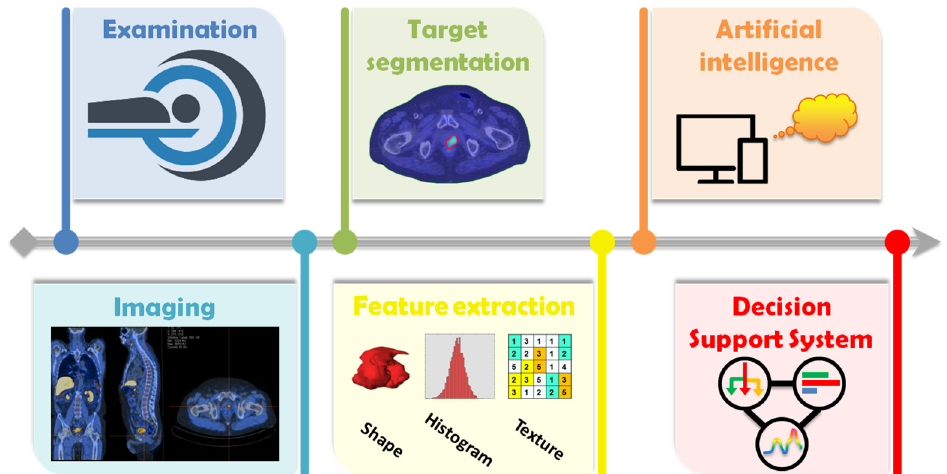
Figure 1. The radiomics framework depicts all the steps needed to build a radiomics model. After medical image acquisition and reconstruction, the region of interest (ROI) is segmented manually, semi-automatically or fully automatically. The feature extraction step, including post-processing of the acquired image, provides numerous quantitative biomarkers managed by means of artificial intelligence to achieve a clinical decision support system.